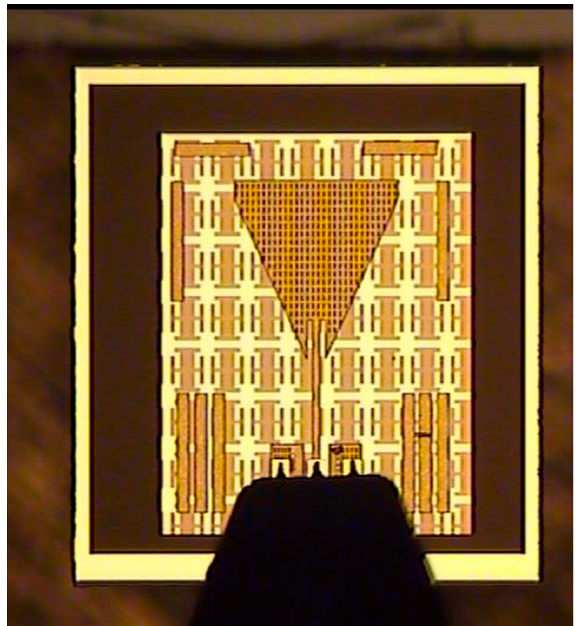
Figure 20. GSG connector and actual measurement diagram.